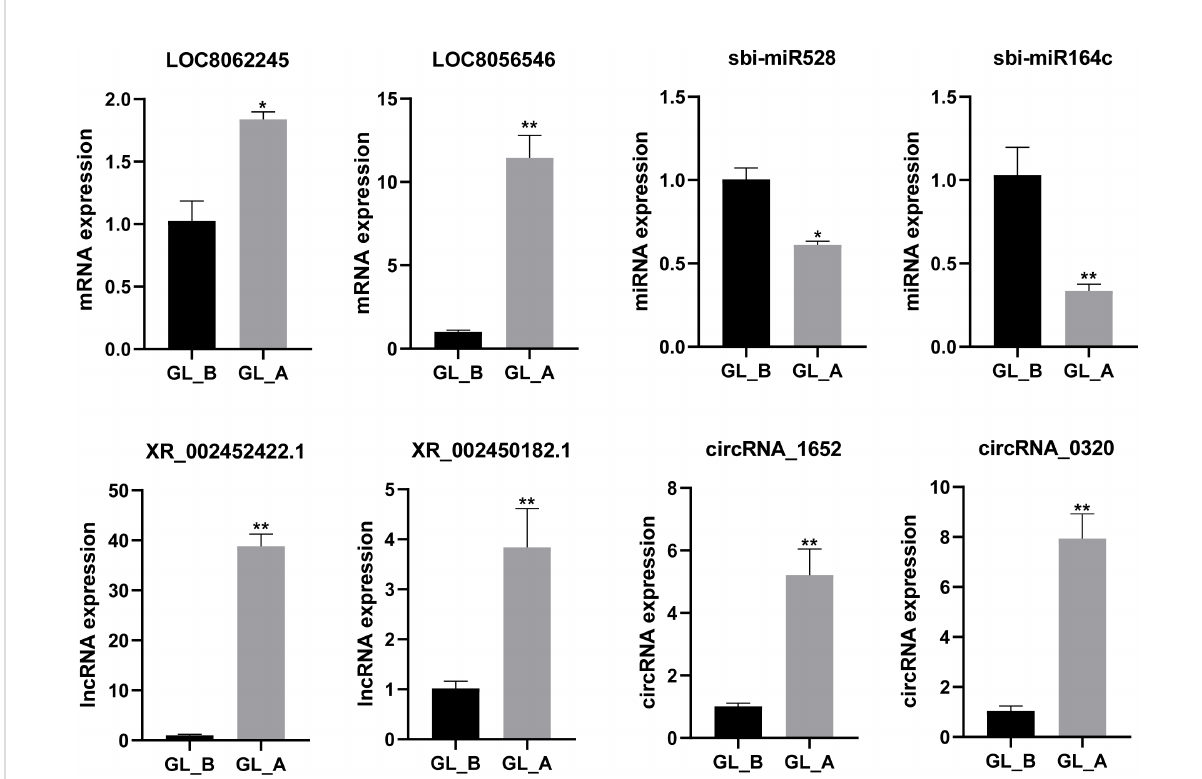
FIGURE 8 Quantitative real-time PCR (qRT-PCR)-mediated con fi rmation of select differentially expressed (DE)-mRNAs, DE-miRNAs, DE-lncRNAs, and DE- circRNAs in sorghum ( “ Jitian 3 ” ) between GL_A and GL_B groups. All data are provided as mean ± SEM, n = 3, * p < 0.05, ** p <